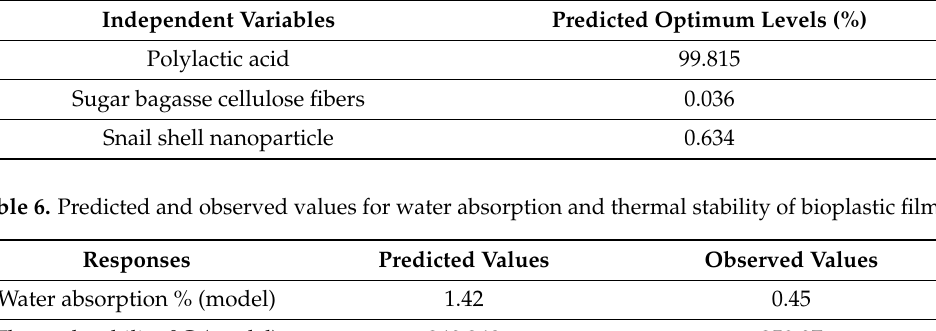
Table 5. Optimum loading variables for water absorption and thermal stability of bioplastic films.